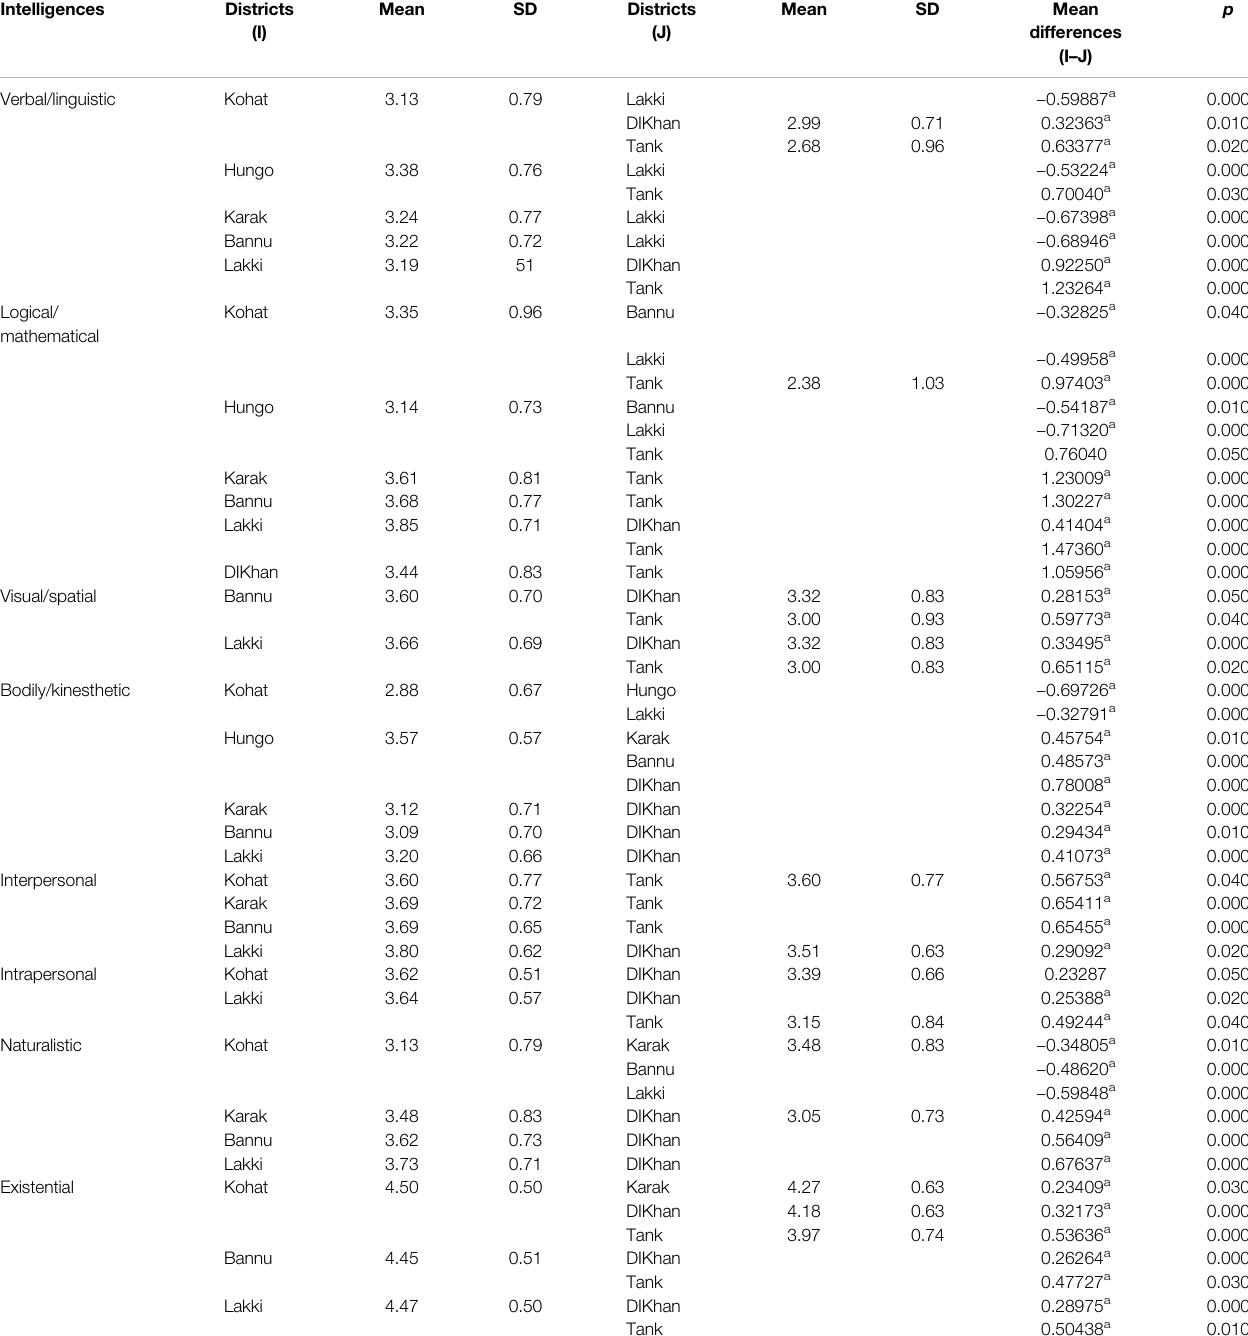
TABLE 3 | (Schef fi e) Post hoc test on the students ’ self-estimates of multiple intelligences of seven districts ( N (cid:1) 905). Intelligences Districts Mean SD Districts Mean (I) (J)